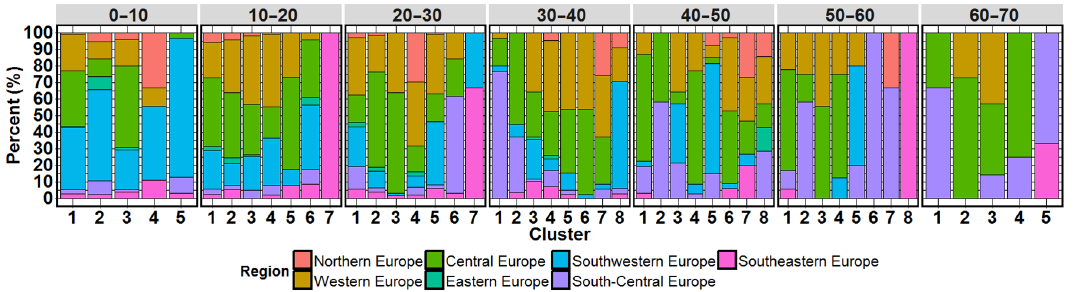
Figure 3. The proportion of sites in each 2010–2014 average annual NO 2 (NO 2AA ) 10µgm − 3 concentration bin in different European regions (shown in Fig. S2), separated by clusters demarcating distinct variation in monthly, hour of day, and hourly NO 2 concentration bin contributions to NO 2AA